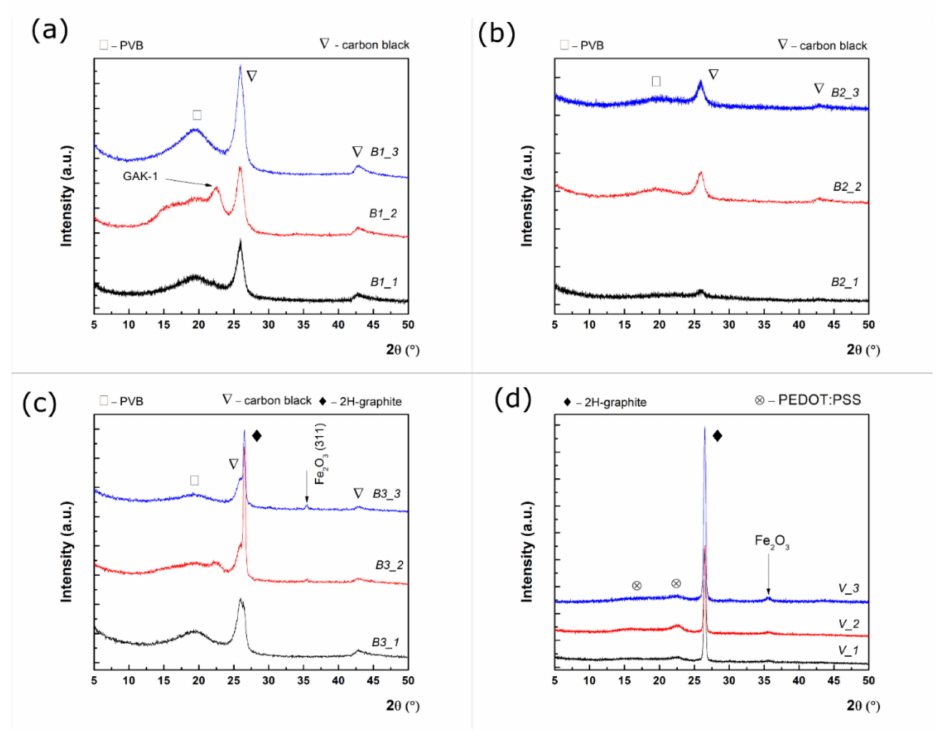
Figure 6. GIXRD patterns for ( a ) B1, ( b ) B2, ( c ) B3, ( d ) V